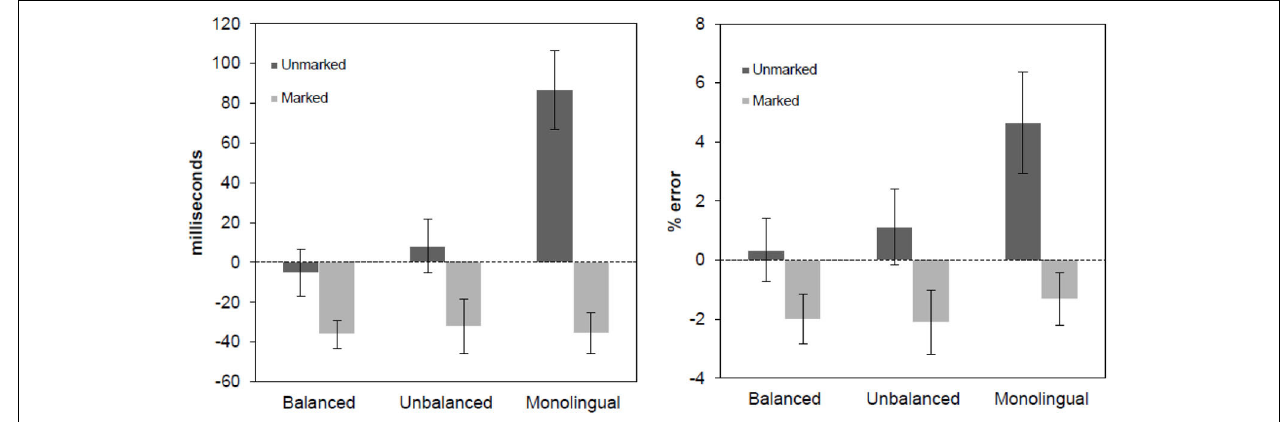
FIGURE 1 | Language effect in reaction times (left panel) and error rates (right panel) for speeded language decision task, separated by marked and unmarked conditions. The effect was